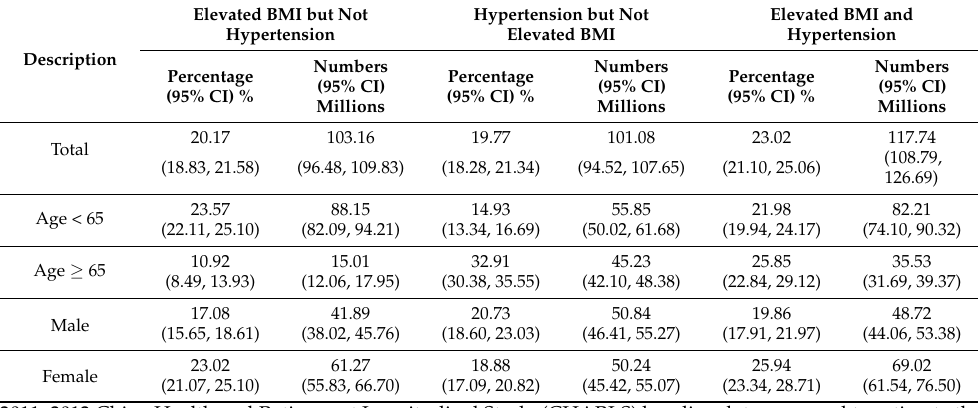
Table 1. Percentage and numbers of Chinese adults who have hypertension 1 , elevated body mass index (BMI) 2 , or